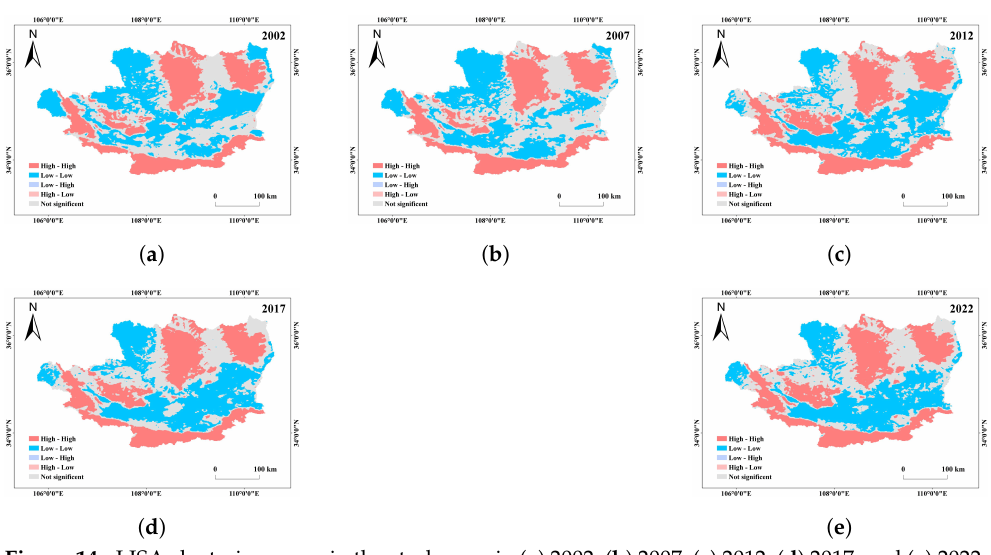
Figure 14. LISA clustering maps in the study area in ( a ) 2002, ( b ) 2007, ( c ) 2012, ( d ) 2017, and ( e ) 2022.